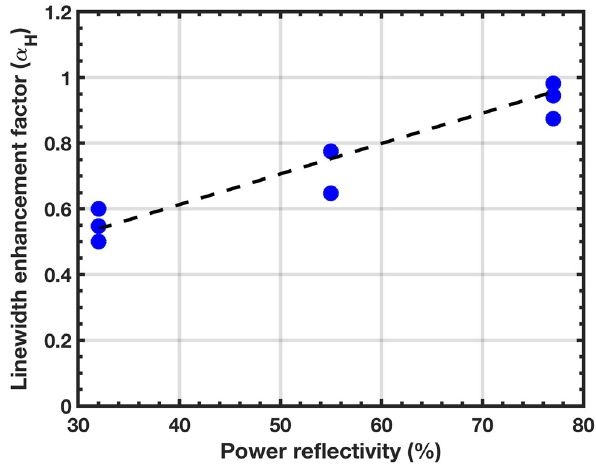
Figure7: Thelinewidthenhancementfactor( α H -factor)measuredas a function of the front facet power re fl ectivity. The back-facet is HR- coated. The dashed line is a guide to the eyes.